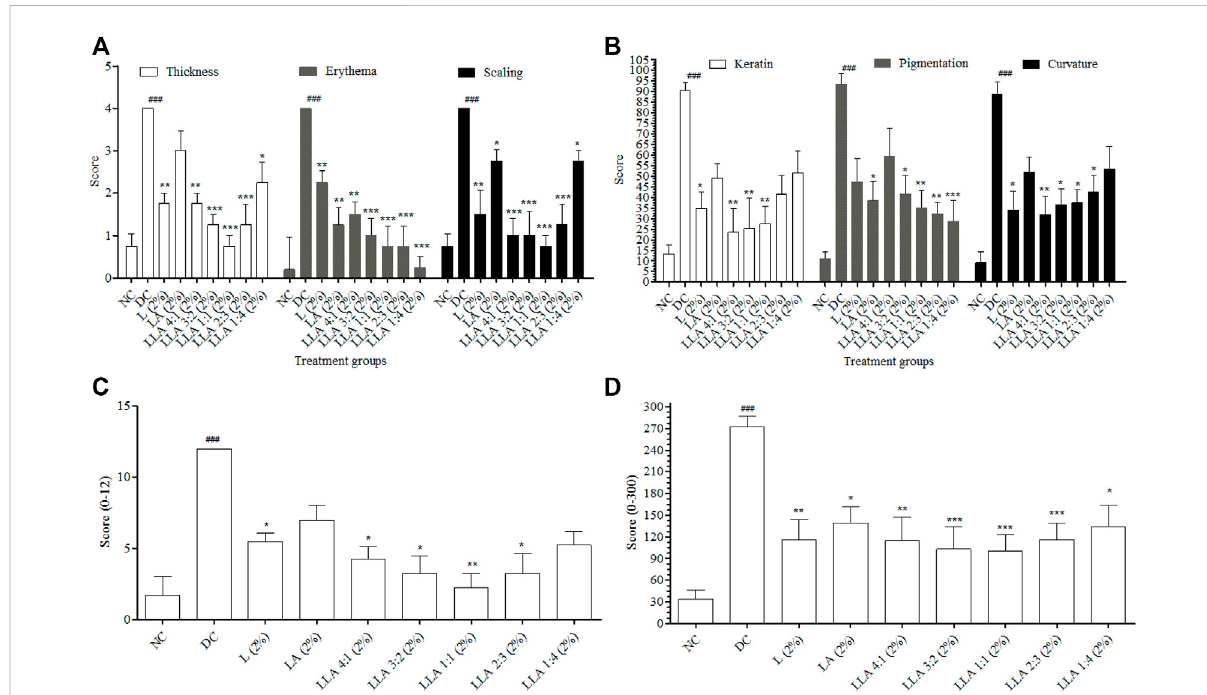
FIGURE 1 Results of PASI and CosCam scores of the mice treated with different ratios of LLA combination. Graph (A) depicts thickness, erythema, and scaling of PASI, (B) depicts keratin, pigmentation, and curvature of CosCam scores, (C) depicts cumulative PASI scores, and (D) depicts cumulative CosCam scoresofthetreatmentgroups.NC;normalcontrol,DC;diseasecontrol,LLA(2%);linalool+linalylacetate in4:1, 3:2,1:1,2:3,and 1:4ratios at2%concentration.Thedatarepresentmean±SEM, n =6. ### p < 0.001(NCvs.DC),* p < 0.05,** p < 0.01,and*** p <